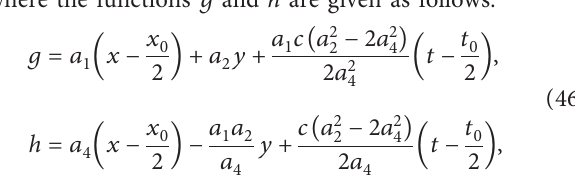
� b � 10, at time t � 1 2